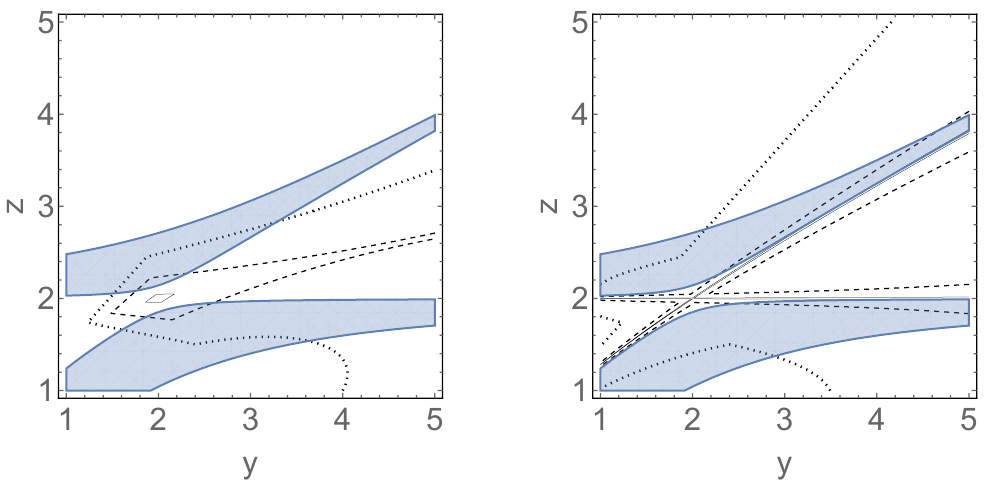
Figure 2 . In the left and right panels, we plot two ratios r 1 and r 2 of eigenvalues of the physical Yukawa couplings ( Y ) to the maximum one at the fixed x = 2 , respectively. The dotted, dashed, ˆ3ˆ a ˆ b and solid curves correspond to the values for 10 − 1 ( 10 − 1 ), 0 . 05 (10 − 2 ) , and 10 − 2 (10 − 3 ) , in the left (right) panel. In both panels, blue shaded regions represent the allowed volume 1 < V ≤ 30 . Note that the Yukawa matrix reduces to the rank-two Yukawa matrix at z = y + the vicinity of the solid curves.